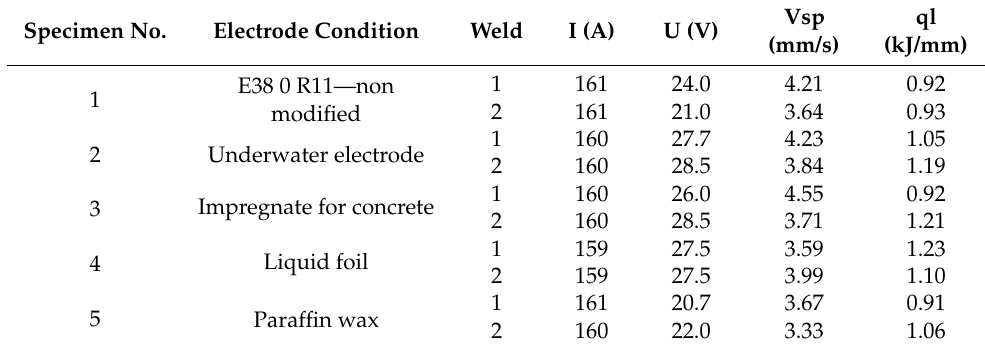
Table 4. The welding